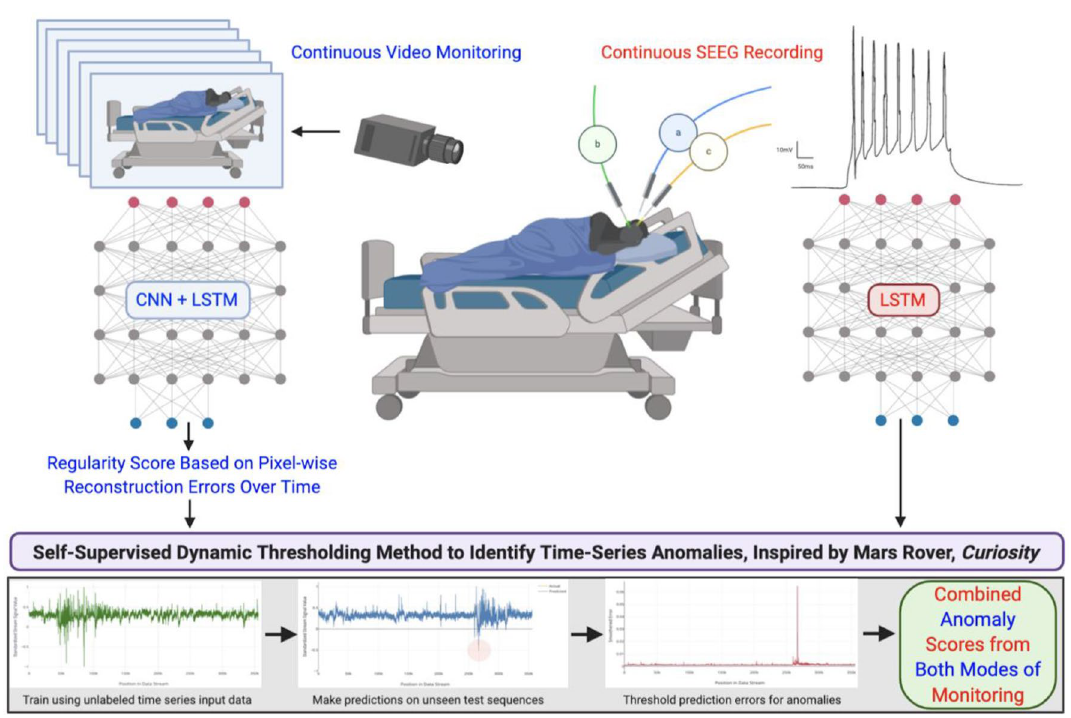
Figure 1. Overview of the workflow for continuous monitoring with video and SEEG and real-time analysis in the epilepsy monitoring unit. Patients with DRE receive continuous monitoring of their intracranial SEEG leads (red) and simultaneous video recording in their hospital beds (blue). A convolutional LSTM autoencoder (CNN + LSTM) was applied to the video recordings to calculate a regularity score for each frame over time. This regularity score time series and the SEEG time series (green sequence, bottom left) were then separately fed into an LSTM network to reconstruct their signals (blue sequence, bottom middle) and calculate a reconstruction error (red sequence, bottom right) which was then subjected to a self-supervised dynamically thresholding method to identify anomalous events in